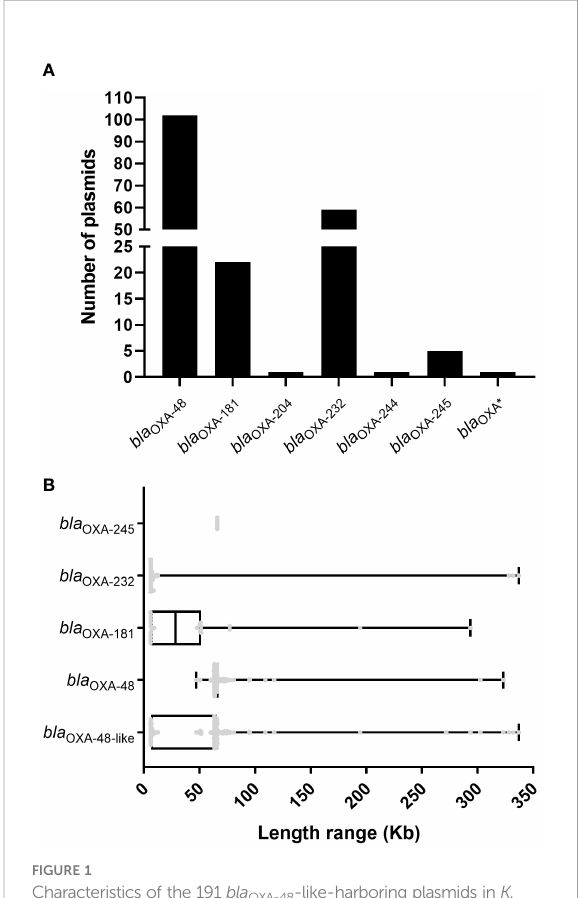
OXA-48 -like bla OXA-232 -harboring plasmids, 22 bla OXA-48 -harboring plasmids,